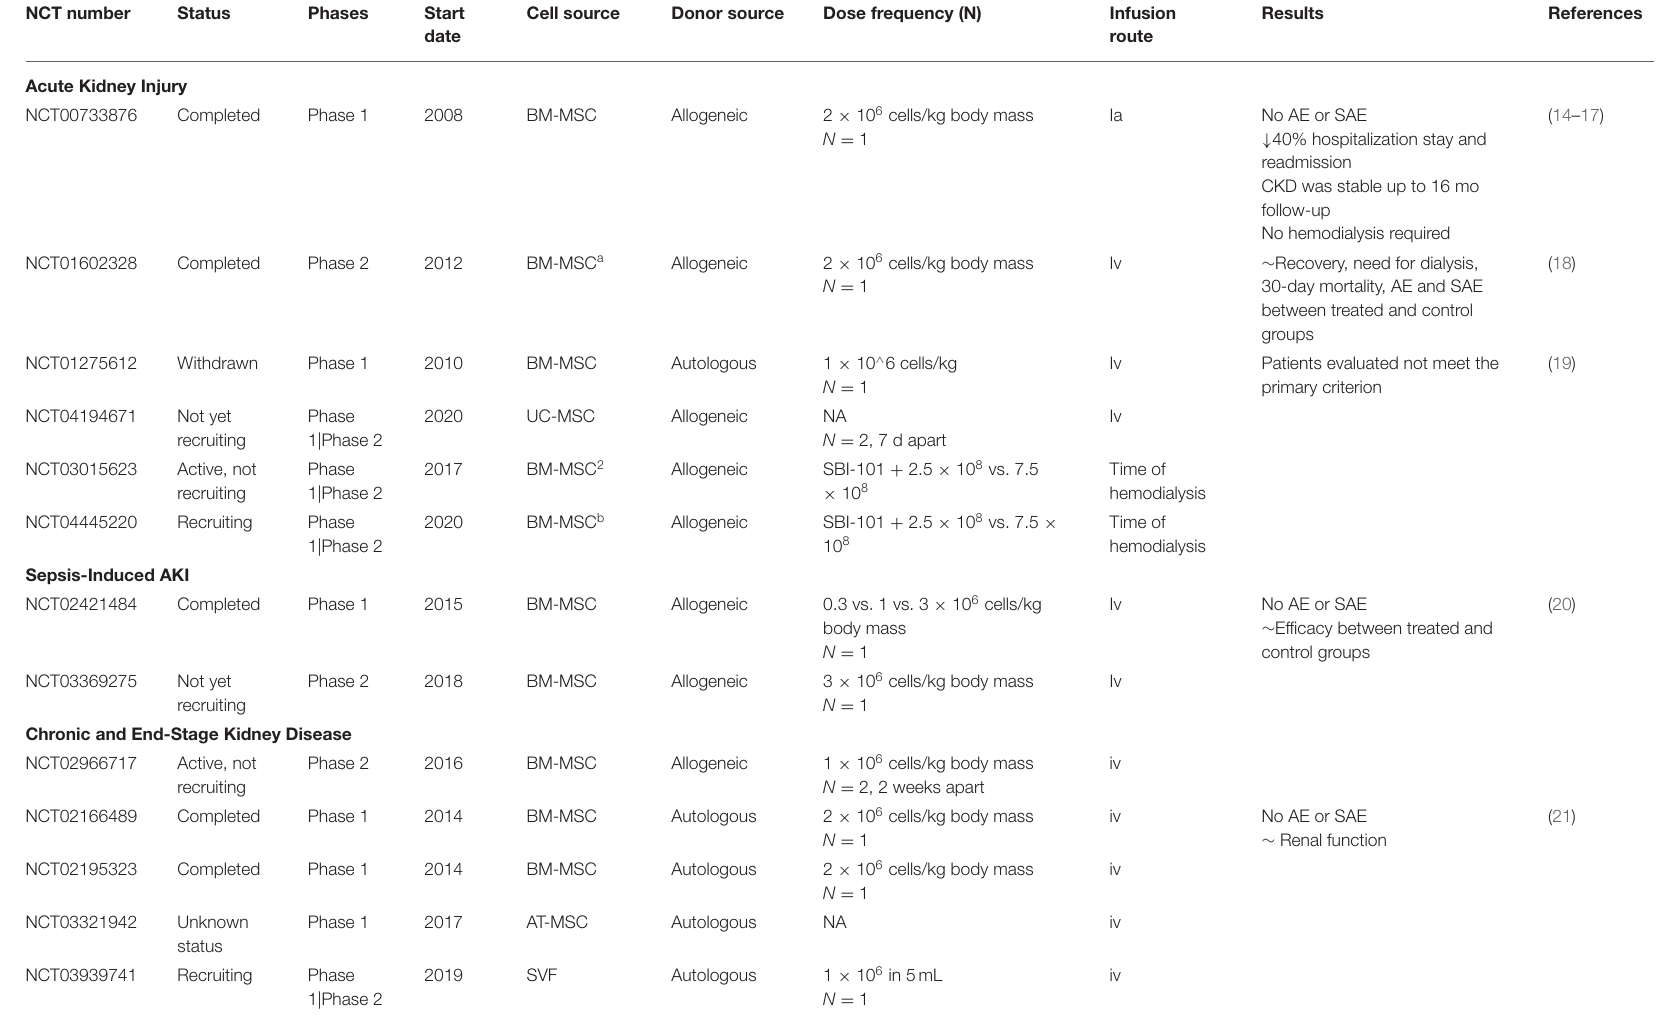
TABLE 1 | Summary of clinical trials in KD using MSC registered at ClinicalTrials.Gov. Search done on 23rd April